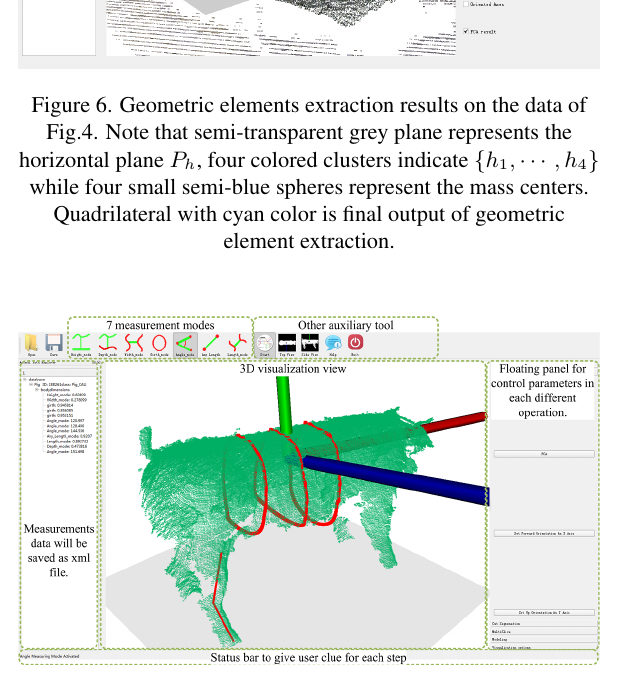
Figure 7. Selected features of the developed livestock body measurement software(Guo et al., 2017).